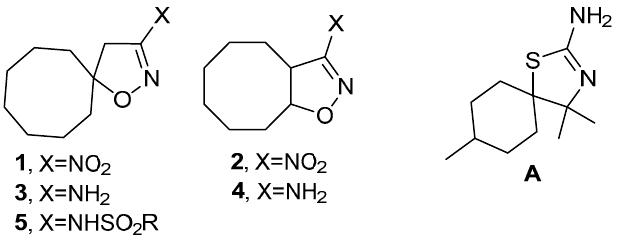
Figure 1. Spiro-heterocycle A , which served as lead for elaboration of agents that act on viral infections and compounds 1–5 synthesized and screened in this work.